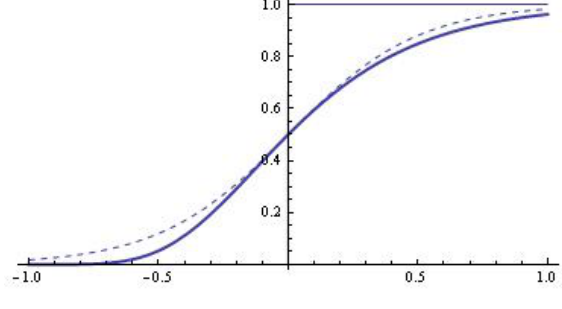
Fig. 6. The logistic (dotted line) and the Gompertz function (dense line) with same point and same rate (at that